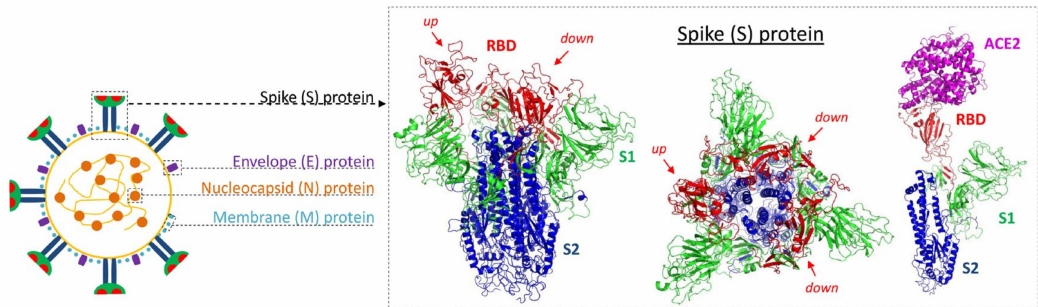
Figure 1. Structure of severe acute respiratory syndrome coronavirus 2 (SARS-CoV-2). Schematic representation illustrating the 4 structural proteins of SARS-CoV-2. Inset shows side (left) and top (middle) view of homotrimeric spike glycoprotein with two of the receptor binding domains (RBD, red) in their down position and one in the up position. The rightmost structure shows a single monomer with the RBD in its up position and bound to human ACE2. Protein structures visualized with PyMol using models from https: //